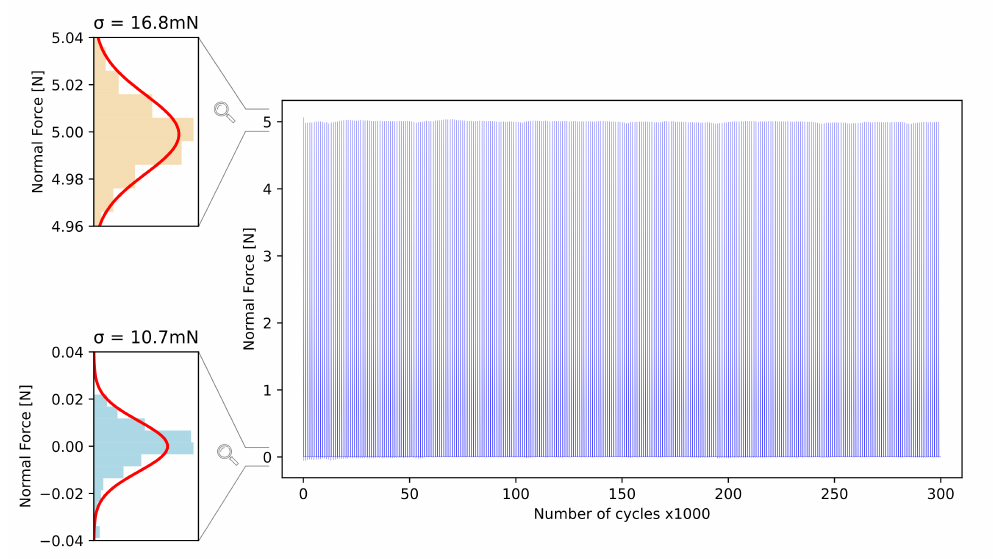
Figure 9. Repeatability error when cycling the normal force between 0 and 5 N up to 300,000